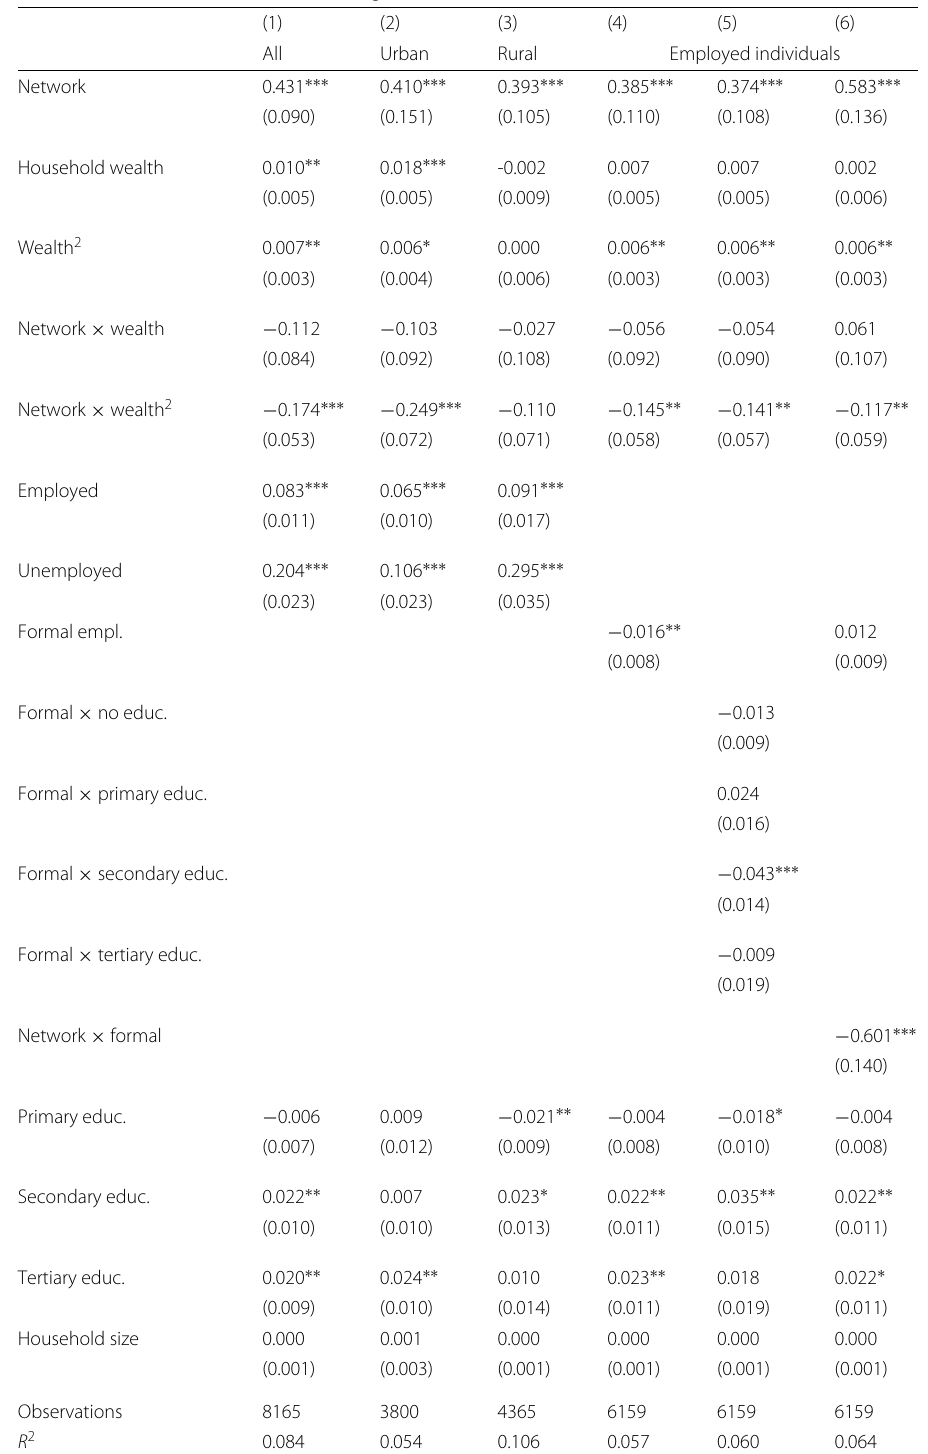
Table 7 Individual determinants of emigration: Labor market factors, OLS results (1) (2) (3) (4) (5) (6) All Urban Rural Employed individuals Network 0.431 ∗∗∗ 0.410 ∗∗∗ 0.393 ∗∗∗ 0.385 ∗∗∗